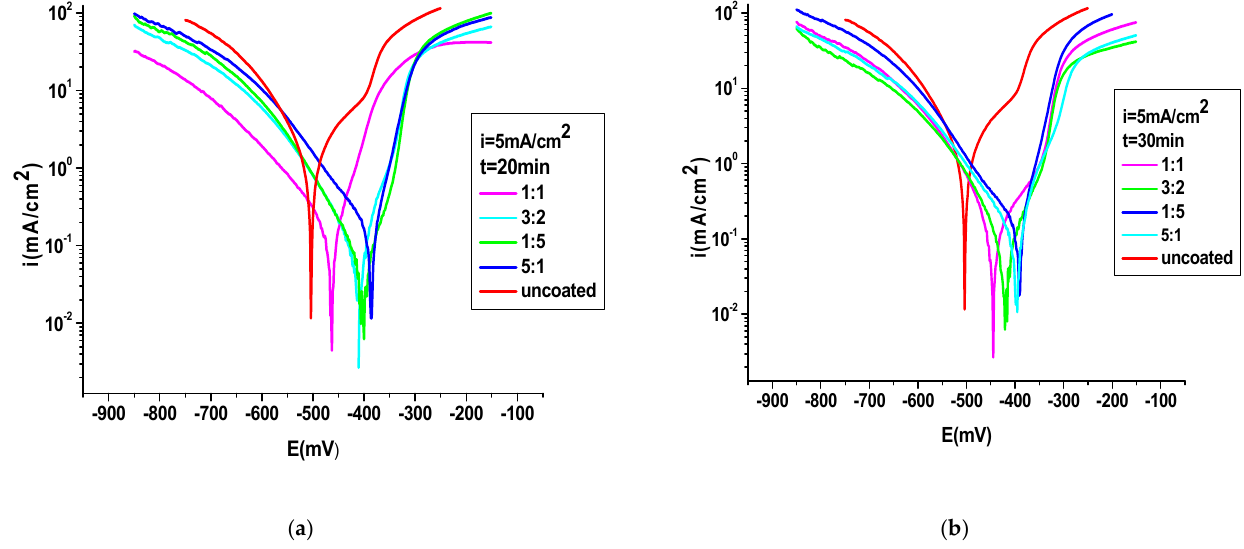
Figure 6. Polarization curves of PNMPY-TRX100/PNNDEA ( a ) coated and ( b ) uncoated of OL 37 in 0.5 M H 2 SO 4 by electrodeposition at 5 mA/cm 2 current density in different molar ratios where the deposition was permitted for 20 and 30 min.